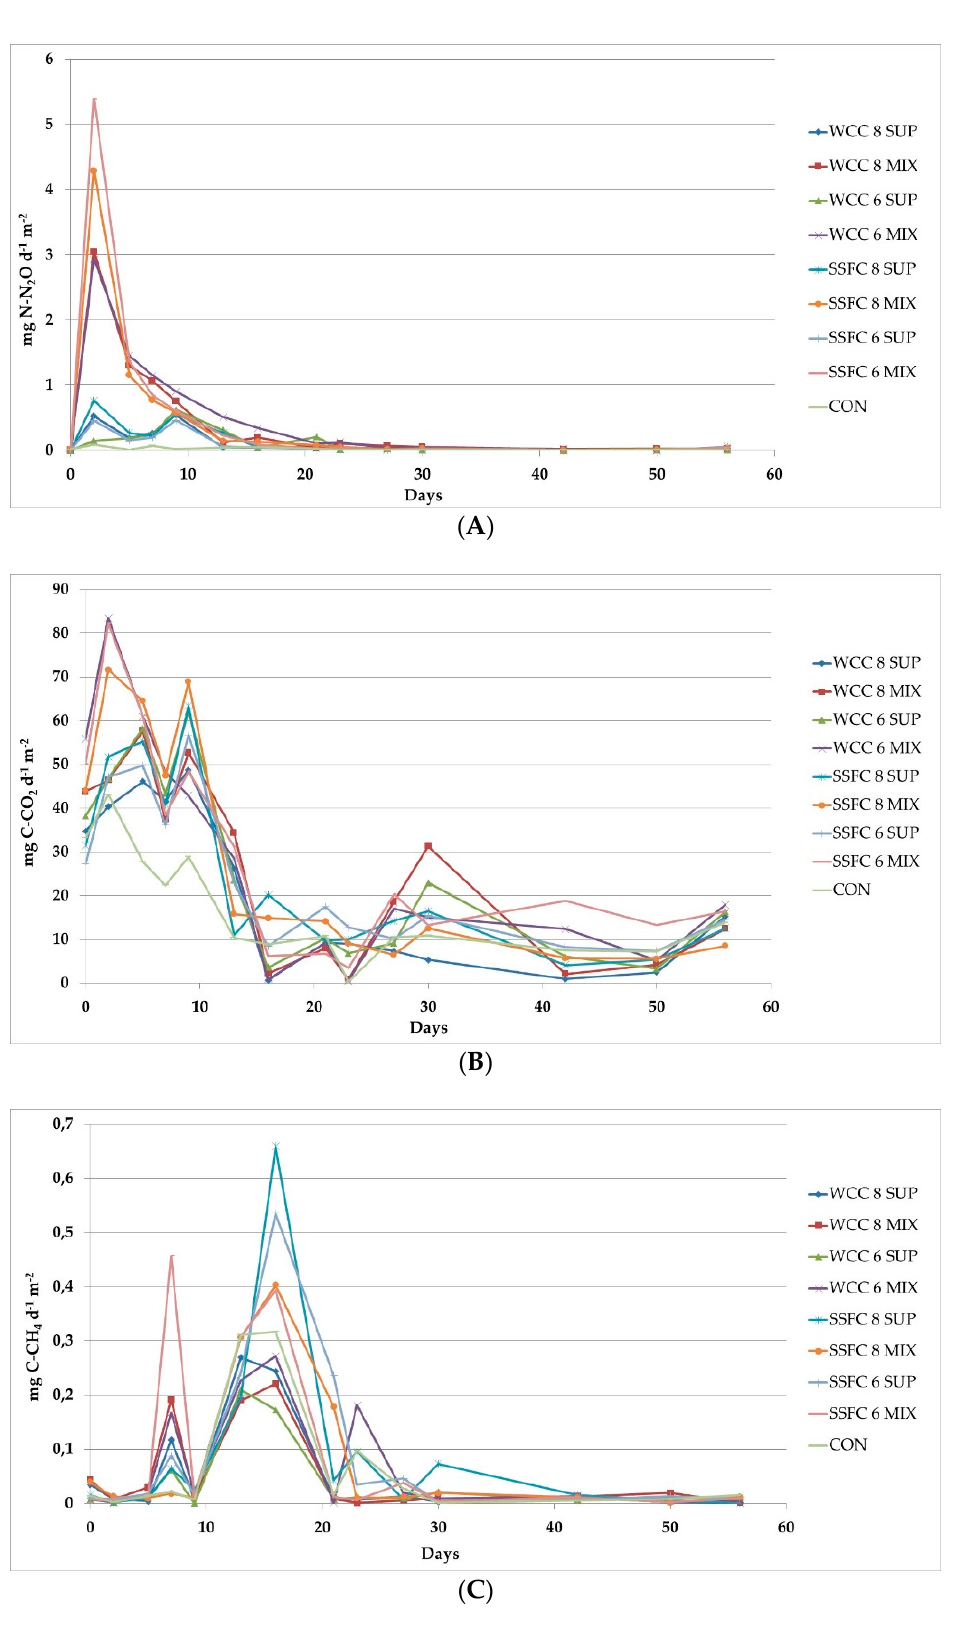
Figure 1. Average N 2 O ( A ), CO 2 ( B ) and CH 4 ( C ) fluxes after soil application of the investigated pellet during the 57 ‐ days incubation period ( n = 4).